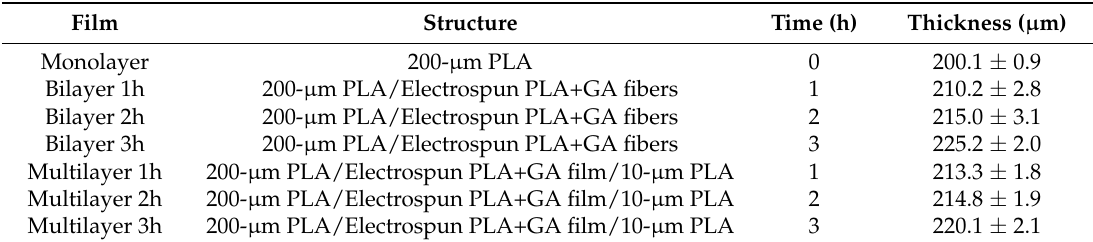
Table 1. Code and total thickness of the polylactide (PLA) films containing gallic acid (GA) according to their structure and deposition time during